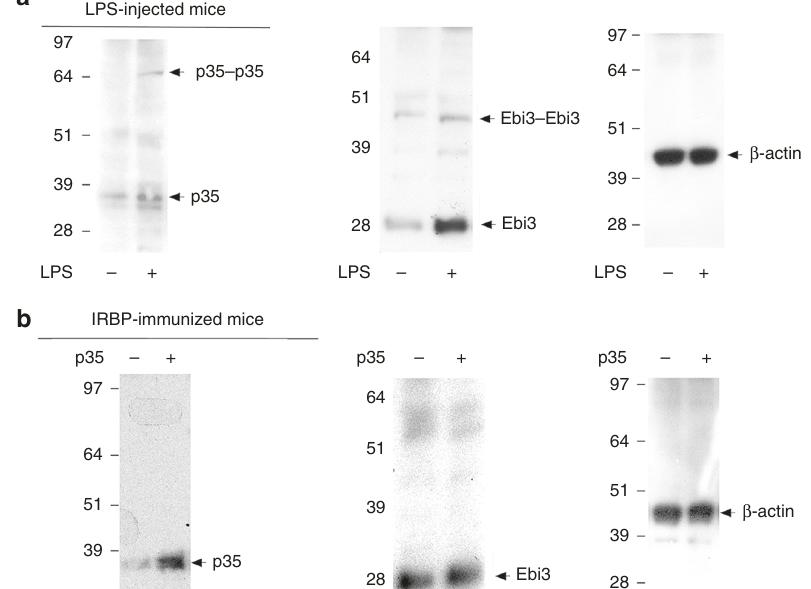
Fig. 2 p35 induced an IL-35-producing Breg cells in vivo. a We injected C57BL/6 mice with LPS (15 µ g/mouse) and after 4 days we isolated CD19 + B cells from the spleen (purity > 96%), lysed the cells and subjected the whole cell lysates to western blot analysis. b Intraocular in fl ammation (uveitis) was induced in C57BL/6J mice by immunization with the ocular autoantigen, IRBP in CFA as described in Methods section. Mice were killed 21 days post-immunization and cell lysate of the spleen was analyzed by western blotting (non-reduced condition). Results represent two independent